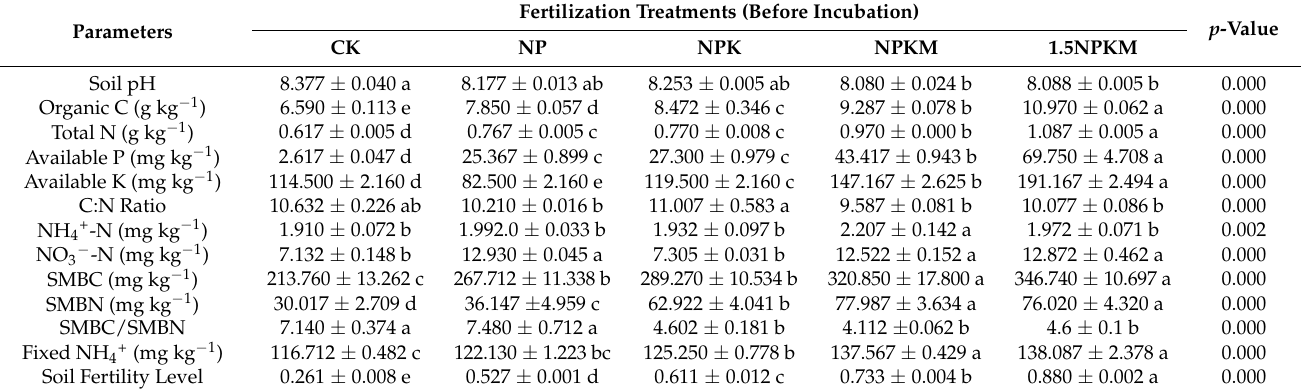
Table 1. Chemical and biological properties of experimental treatments used for incubation study